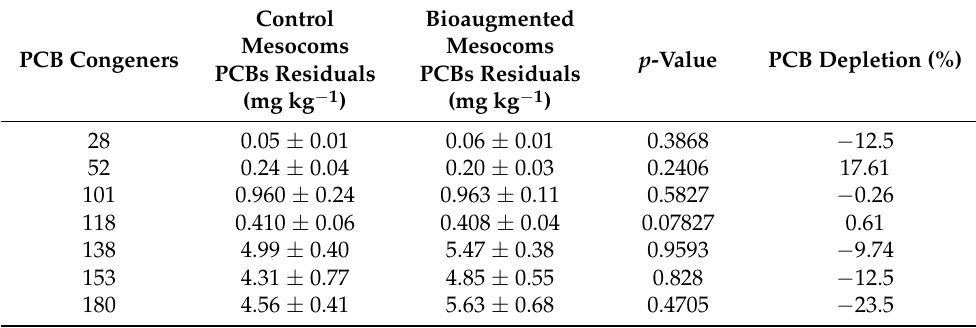
Table 3. Comparison of PCB congener concentrations in bioaugmented and control mesocosms and percentage of degradation of each